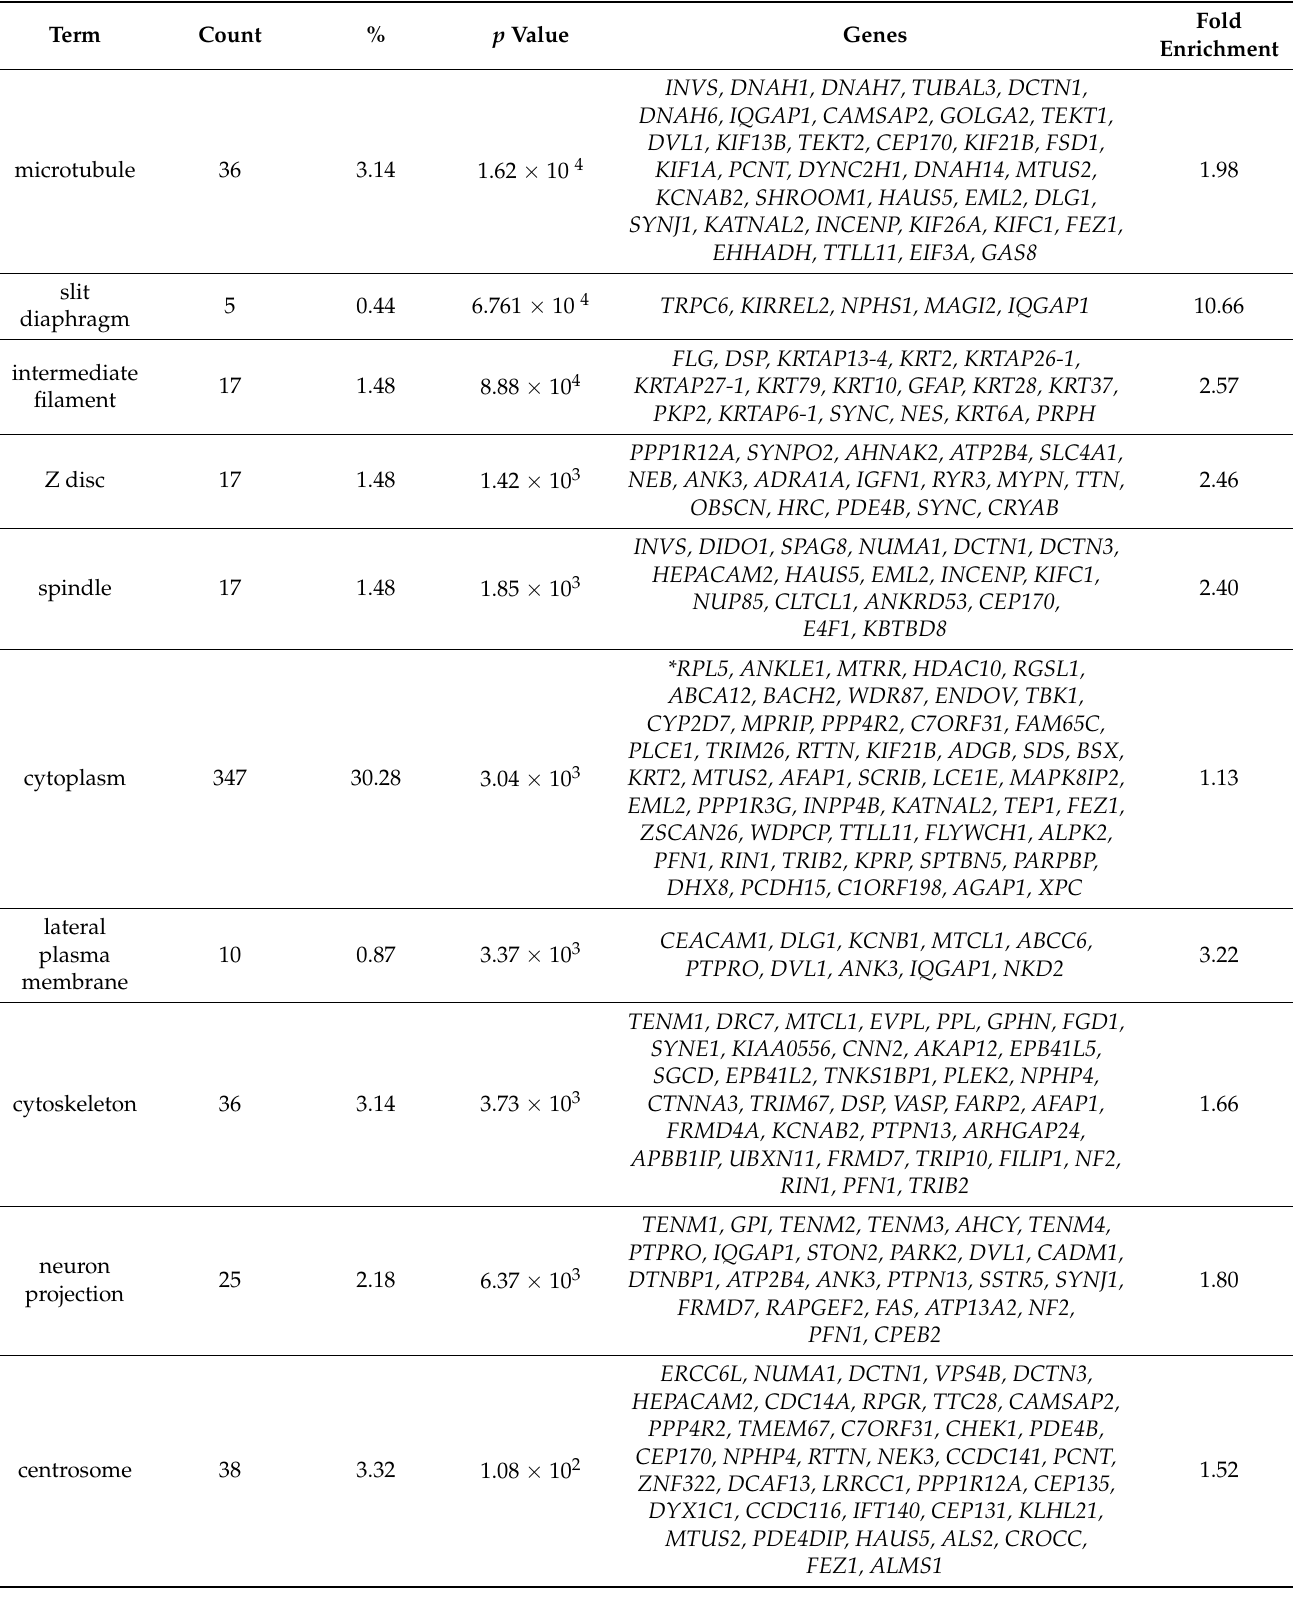
Table 2. Overrepresented Gene Ontology, Cellular Component terms using the combined Minor Allele Frequency (MAF) < 0.05 gene list from all families (input n = 1160). The genes under the terms “cytoplasm” and “plasma membrane” are limited to 50 for brevity. The full list of enriched GO Terms (all GO annotation sets) is provided in Supplementary Files